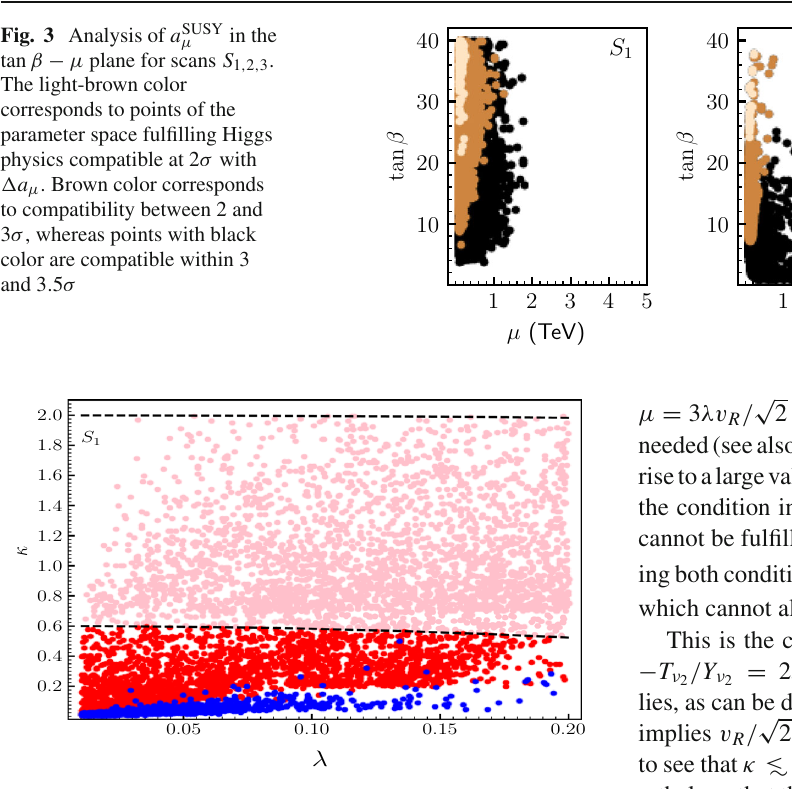
Fig. 4 Viable points of the parameter space for S 1 in the κ − λ plane. The red and light-red (blue) colours represent cases where the SM-like Higgs is (is not) the lightest scalar. All red and blue points below the lower black dashed line fulfill the perturbativity condition up to GUT scale of Eq. (25). Light-red points below the upper black dashed line fulfill the perturbativity condition up to 10 TeV of Eq.